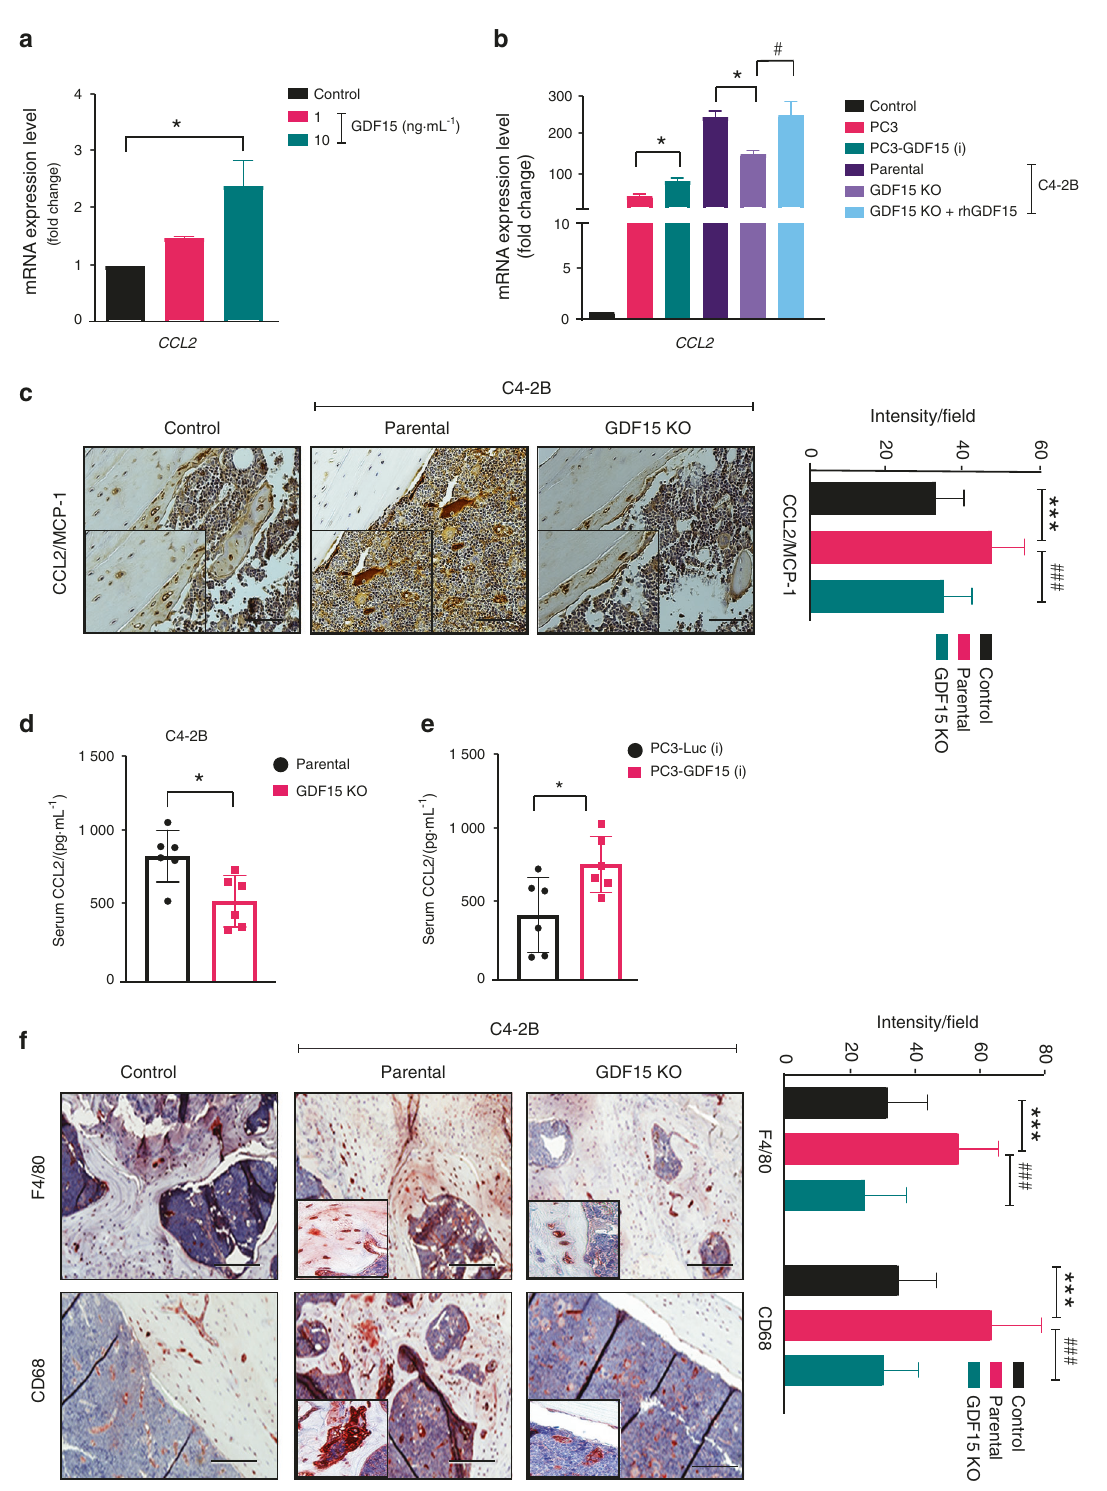
Fig. 3 GDF15 increases the recruitment of bone macrophages (osteomacs) via CCL2. GDF15 increases the expression of CCL2 in osteoblasts. a Total RNA was isolated from MCOs treated with rhGDF15 for 48 h and was assessed for CCL2 by RT – qPCR. b mRNA expression of CCL2 in MCOs after treatment (48 h) with CM from PC3, PC3 cells overexpressing GDF15, C4-2B cells, and C4-2B (GDF15 KO) cells with and without rhGDF15 in vitro. β -Actin was used to normalize the gene expression. c Immunohistochemical analysis of CCL2/MCP-1 in tibial sections from C4-2B- and C4-2B (GDF15 KO)-injected mice ( right panel ) quanti fi cation. Scale bar = 200 µm. d CCL2 levels in serum obtained from C4-2B- and C4-2B (GDF15 KO)-injected mice ( n = 6 mice/group). e Serum CCL2 levels in PC3-Luc(i)- and PC3-GDF15(i)-injected mice ( n = 6 mice/group). f Immunohistochemical analysis of CD68 on F4/80 + macrophages in bone sections obtained from C4-2B- and C4-2B (GDF15 KO)-injected tibiae; ( right panel ) quanti fi cation ( n = 3 mice/group). Scale bar = 200 µm. The data are presented as the mean ± SEM, and P ≤ 0.05 was considered to indicate statistical signi fi cance. * P < 0.05, *** P < 0.001 compared with the control group and # P < 0.05, ### P < 0.001 compared with the parental (C4-2B)-injected